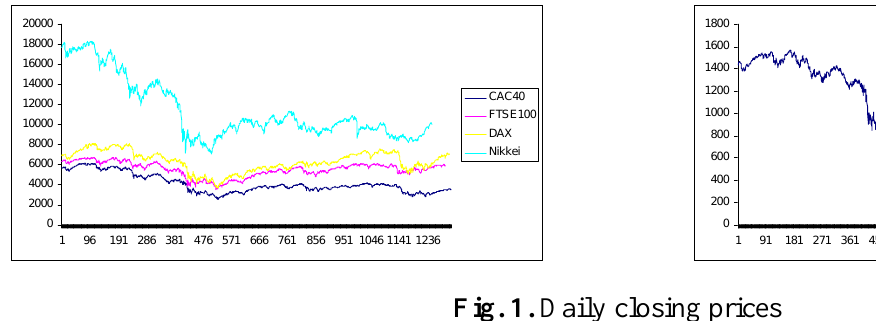
Fig. 1. Daily closing prices